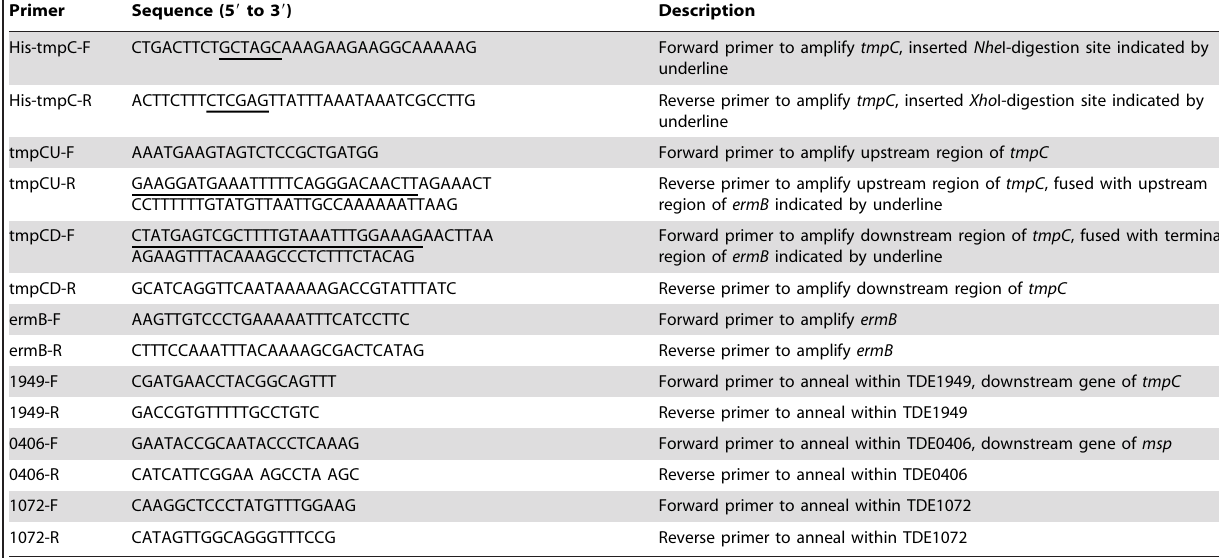
Table 1. Primers used in this